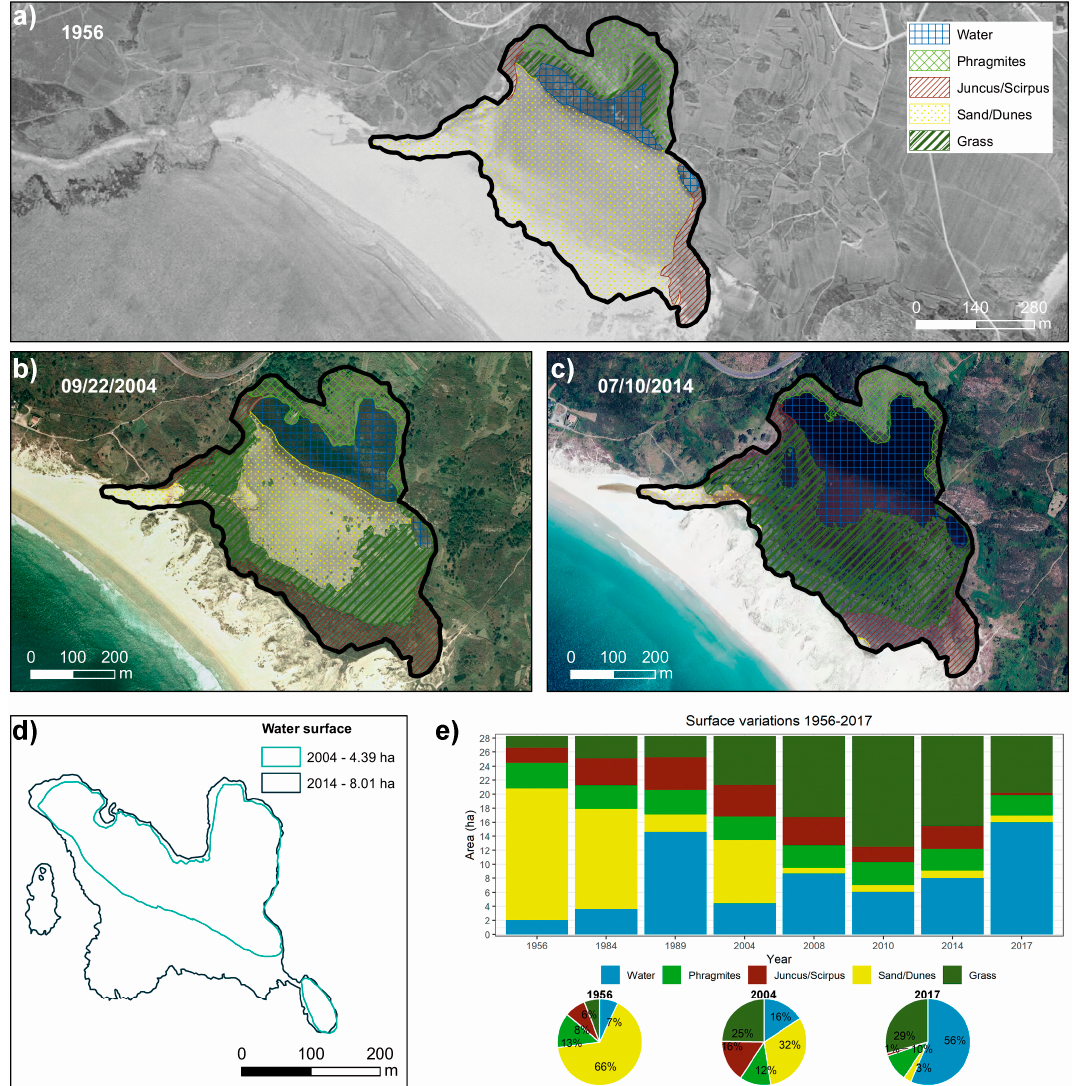
Figure 2. Cartography and data of the Louro lagoon. ( a ), ( b ), and ( c ) represent the areas covered by each category in 1956, 2004, and 2014, based on the aerial images taken each year by the Spanish National Geographical Institute (Instituto Geográfico Nacional de España, IGN). ( d ) shows variations in the free water body between two different dates: 2004 and 2014, and ( e ) shows the area (in hectares, ha) covered by each category in the different dates, as well as the percentage they represented relative to the total area of the lagoon.